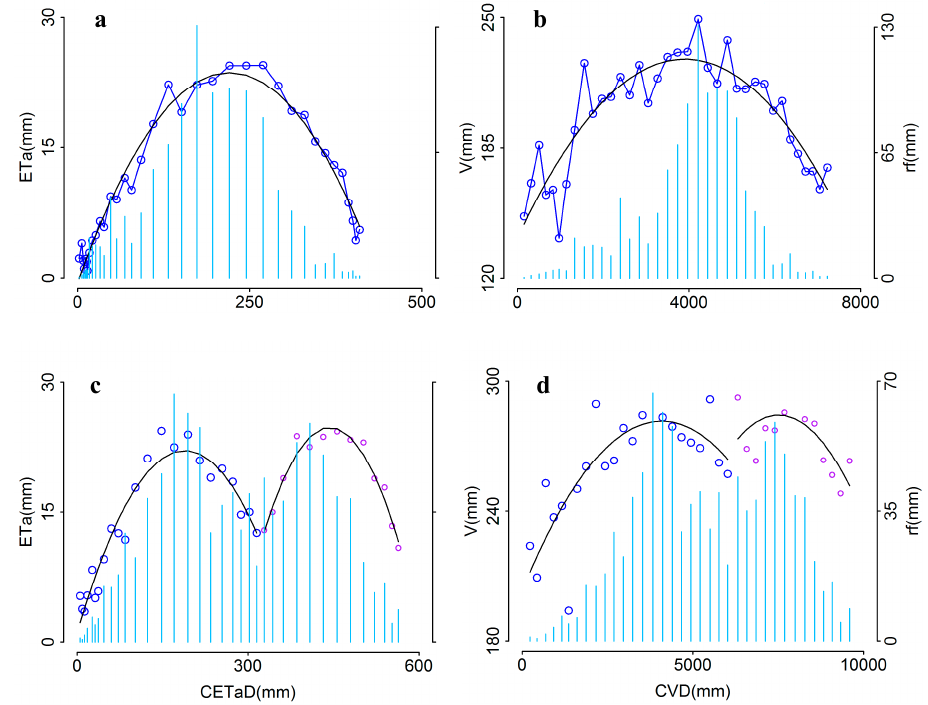
Figure 10. Quadratic model fits for average growing season (2003–2015) at a unimodal site (#48) in Ethiopia for ( a ) ETa (r 2 = 0.97) and ( b ) V (r 2 = 0.79) and at a bimodal site (#14) in Tanzania for ( c ) ETa (r 2 = 0.93, 0.96) and ( d ) V (r 2 = 0.63, 0.38). Blue bars are rainfall (rf) graphs for the same period. Note the relative dynamics of ETa and V in relation to rf, and the differences in axis scaling by site.